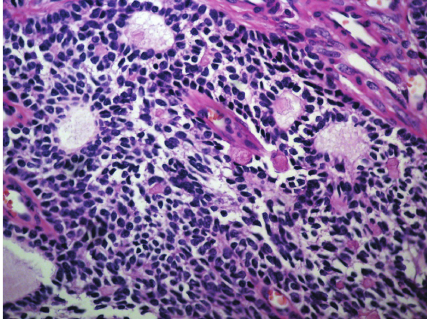
Figure 3: The tumor shows an area with many characteristic Call- Exner bodies (H&E × 400).